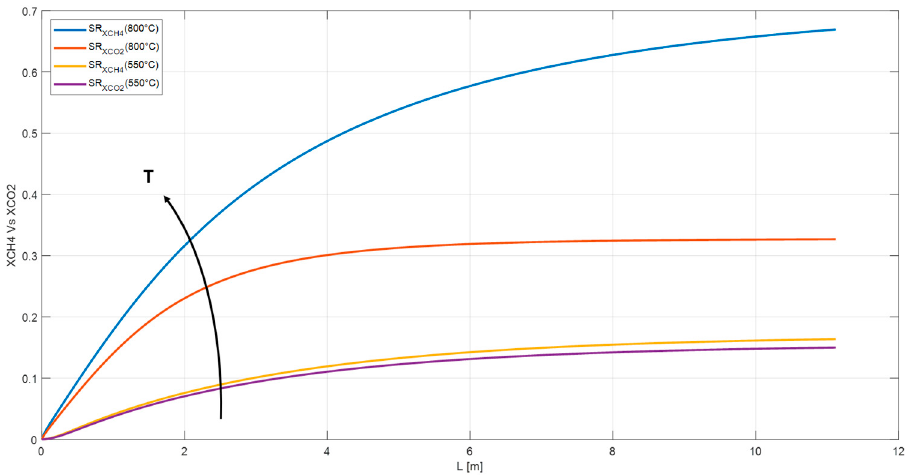
Figure 5. Methane conversion and carbon dioxide yield in a SR operating at 800 °C and 550 °C respectively.